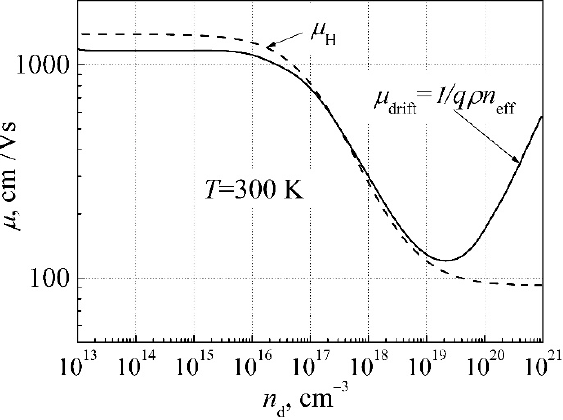
Figure 9. The Hall mobility [26] and drift mobility (Equation (14)) dependences on the donor density in silicon at room temperature.